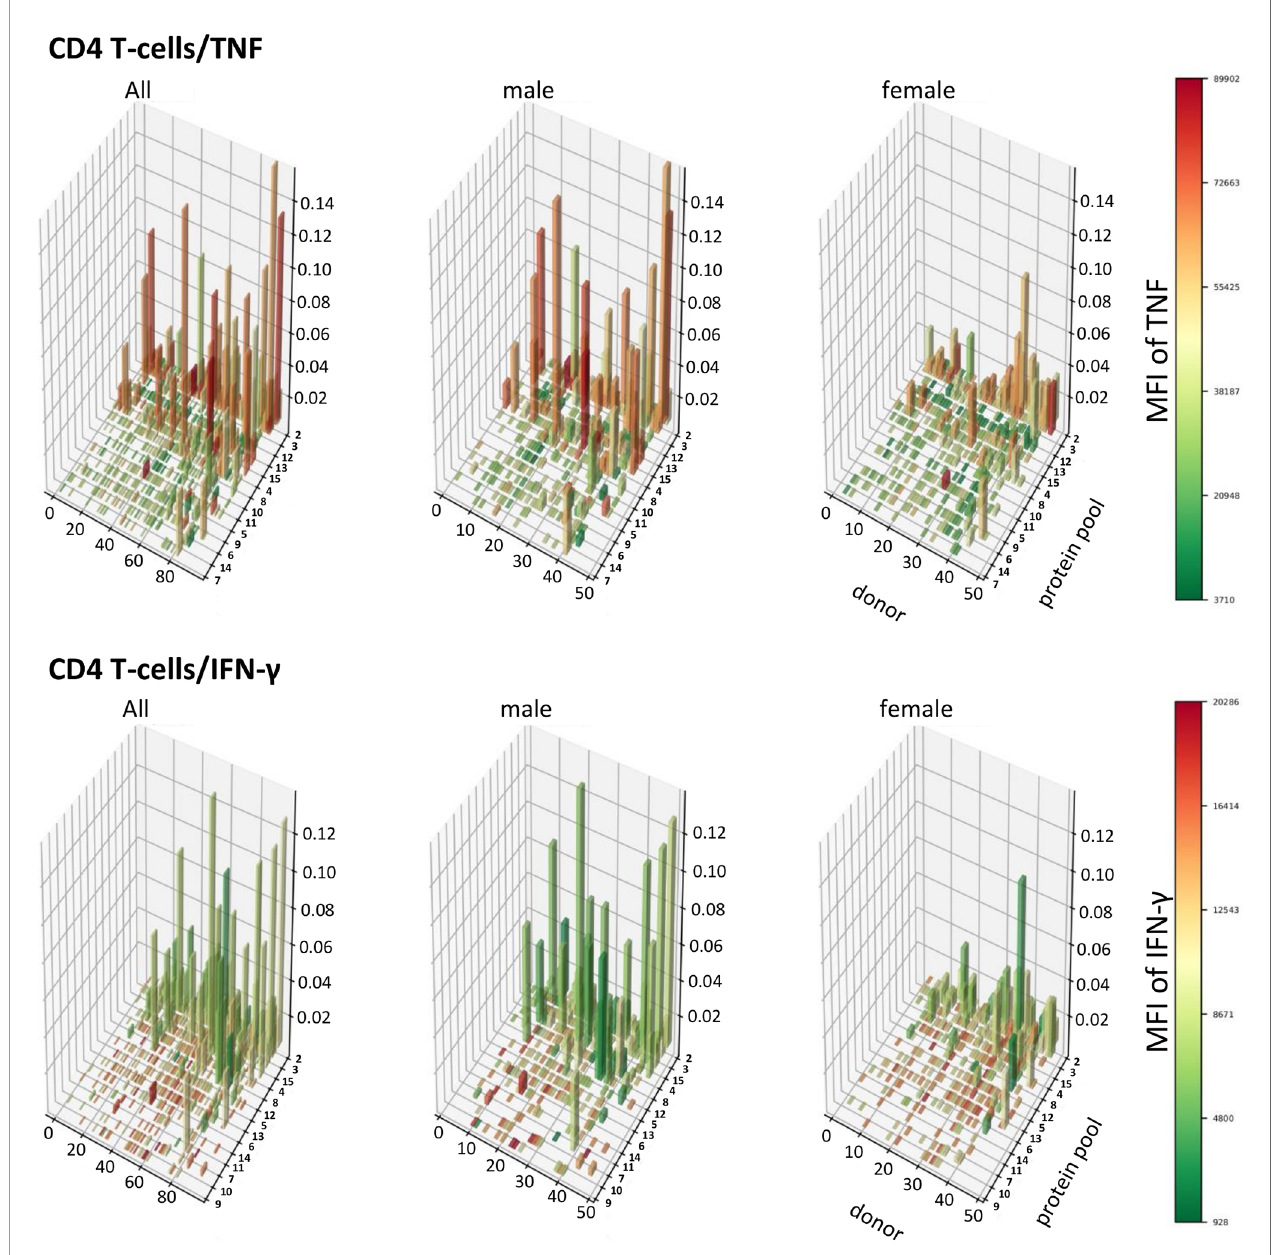
FIGURE 8 | Large CD4 T-cell responses producing high levels of TNF are found preferentially in men. 3D bar charts show all individual CD4 T-cell responses to each CMV peptide pool in the entire population (left), men alone (middle) and women alone (right). Participants are ordered by increasing median T-cell response size from left to right with respect to the entire population. Peptide pools are ordered by increasing median response size induced from front to back, also with respect to the entire population. Bar height corresponds to the percentage of cytokine producing CD4 T-cells, i.e., response size. Bar color corresponds to the MFI of the measured cytokine according to the displayed